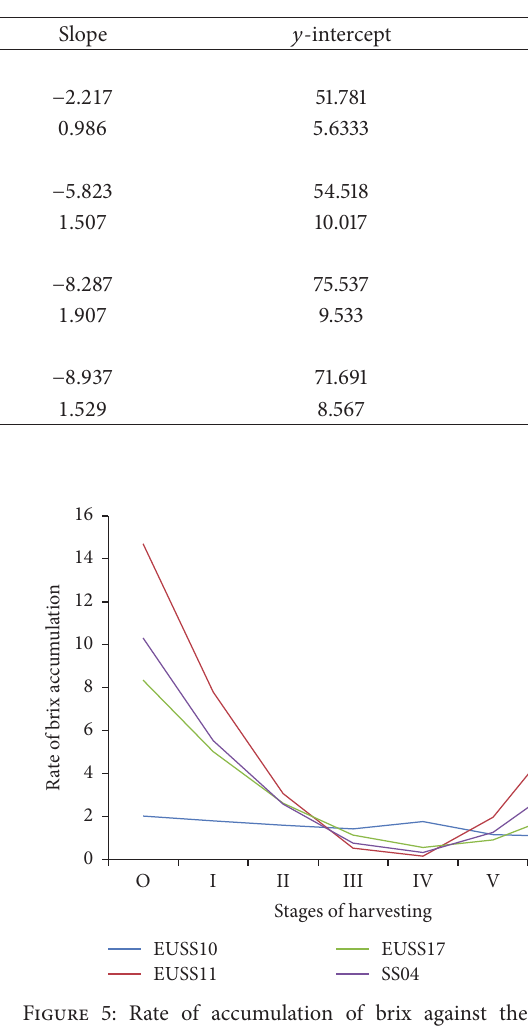
Table 5: Estimated linear regression parameters of four genotypes of sorghum on the rate of response of chlorophyll content and brix to six harvesting stages.